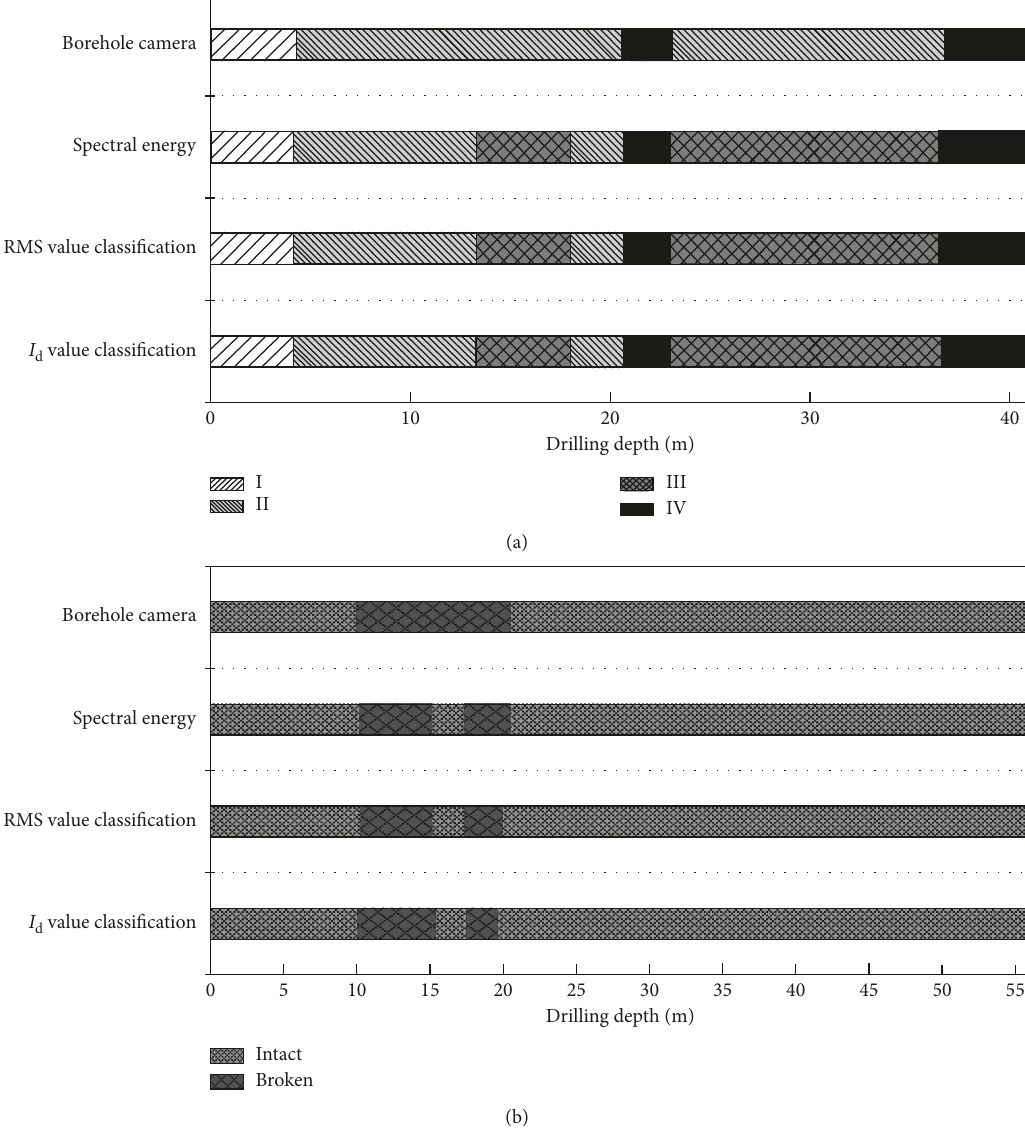
Figure 21: Comprehensive analysis and comparison between different